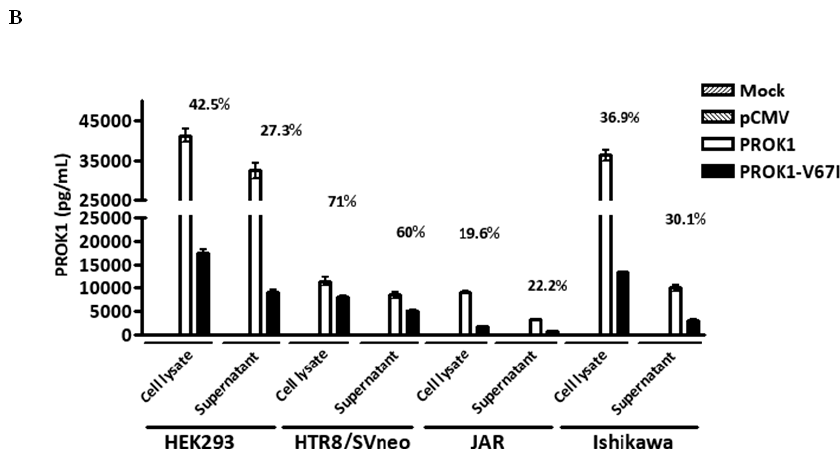
Figure 2. Decreased gene expression of PROK1 variant (V67I) compared with wild-type (WT) in different cell lines. Cells were transiently transfected with either WT or variant PROK1 construct for 48 h. ( A ) Quantitative RT-PCR analysis showed decreased transcript level of V67I compared with WT in cell lines (HEK293 cells: 50.5%; HTR-8/SV neo cells: 64%); ( B ) ELISA analysis showed consistently decreased protein concentrations in the cell lysate and supernatant of the culture medium among different cell lines (HEK293 cells: 42.5%–47.5%; HTR-8/SV neo cells: 60%–71%; JAR cells: 19.6%–22.2%; and Ishikawa cells: 30.1%–36.9%). The comparison of V67I and WT is shown in percentages. Data are presented as means ± SEM. * p < 0.001 compared with the corresponding control (WT). Mock: cells without transfecting any vectors; pCMV: cells with transfecting empty control vectors.